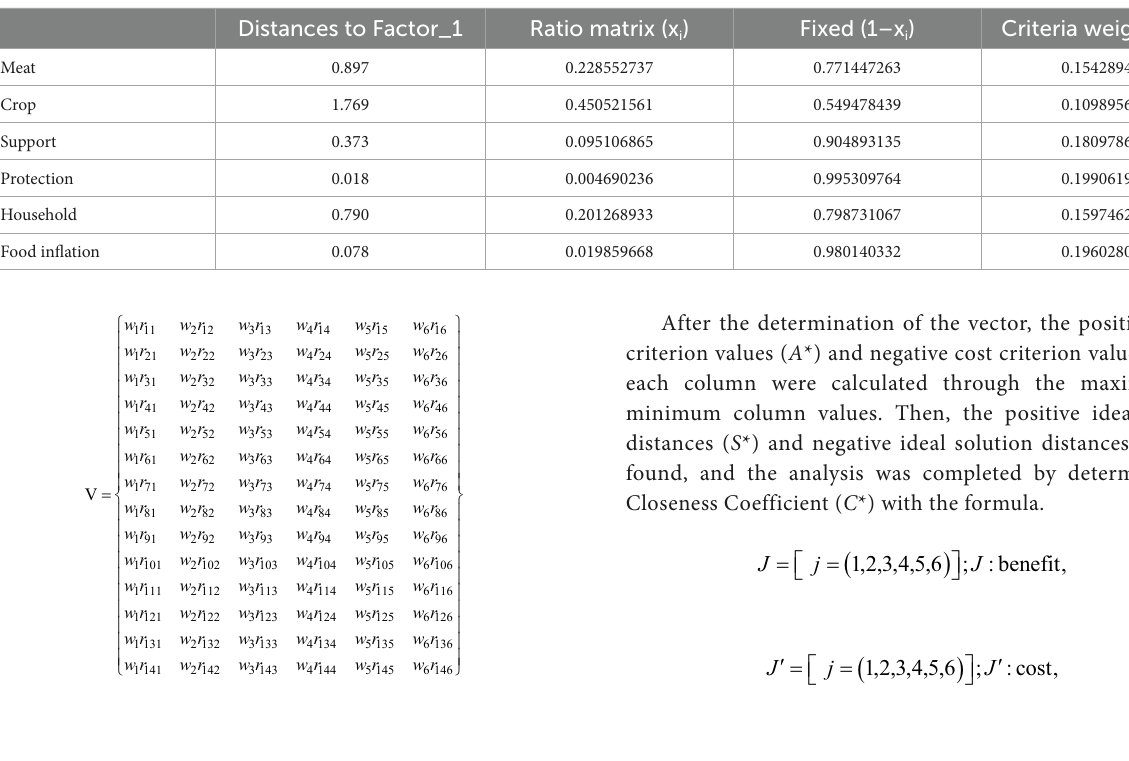
TABLE 4 Criteria weights